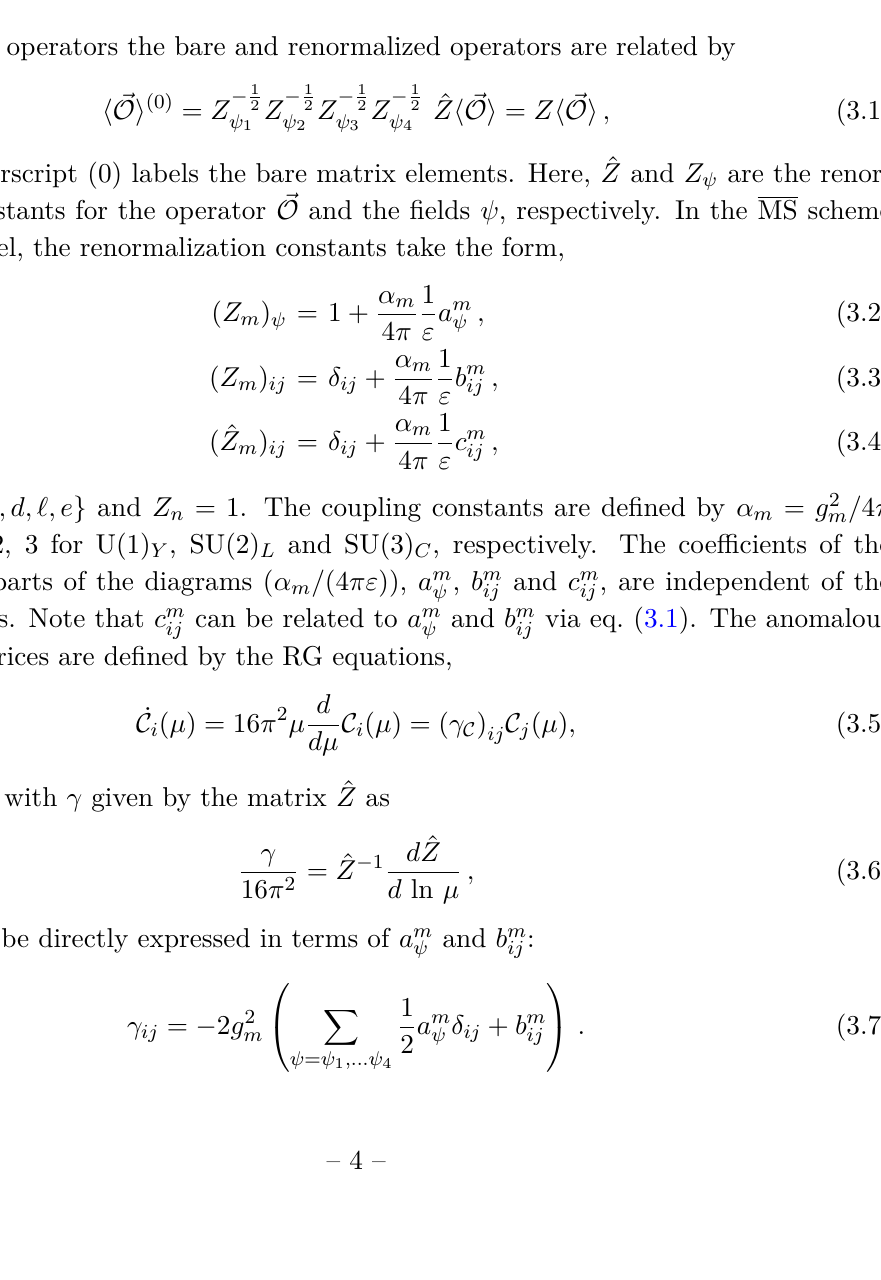
indices are denoted by i, j , and I L